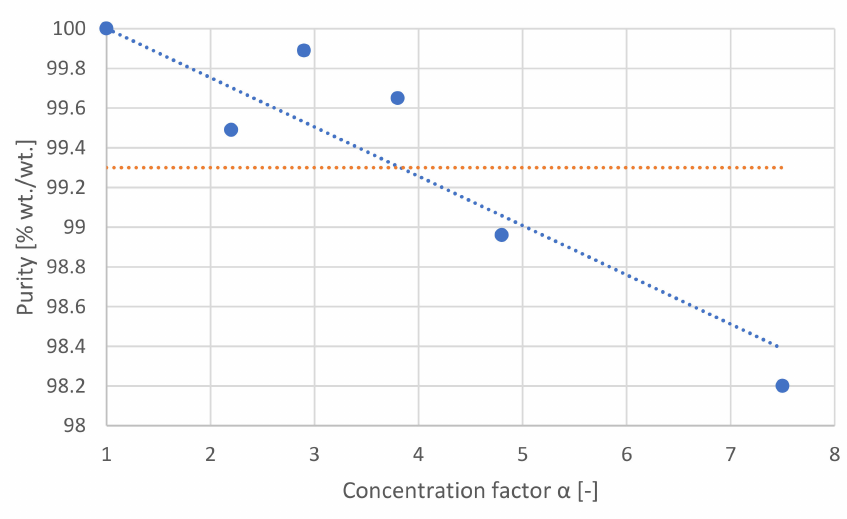
Figure 6. Purity of the product as function of the concentration factor of soluble impurities / byproducts after multi-stage crystallization with crystal washing (15% compared to solids) (blue) and the requested purity